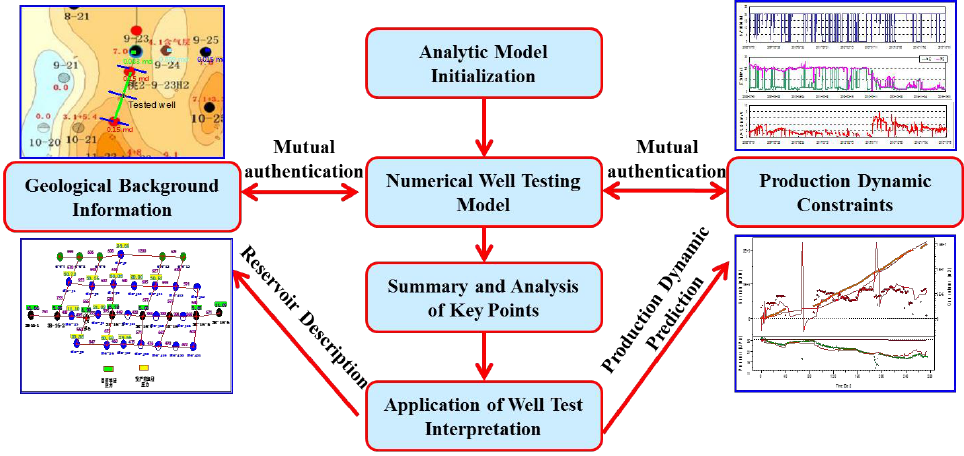
Figure 1—Numerical well testing